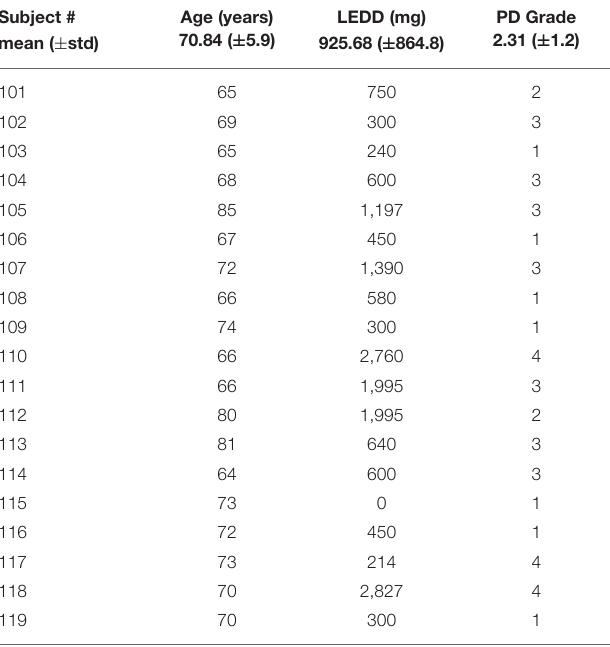
TABLE 1 | Description of 19 patients with Parkinson’s disease.